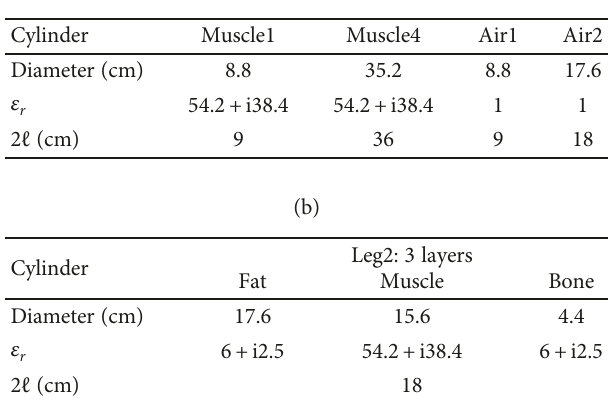
Table 1: Diameter, relative permittivity and mesh size of the test objects: homogeneous dielectric circular cylinders Muscle1, Muscle4, Air1 and Air2, and an inhomogeneous dielectric cylinder Leg2. The permittivity for muscle is from [19], that for bone and fat is based on